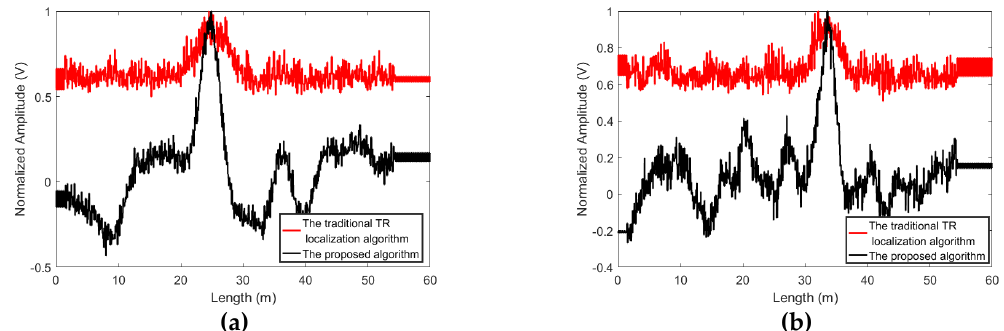
Figure 7. The localization results obtained by using the proposed algorithm and the traditional time reversal localization algorithm at SNR = −5dB, ( a ) L1 and ( b ) L2.